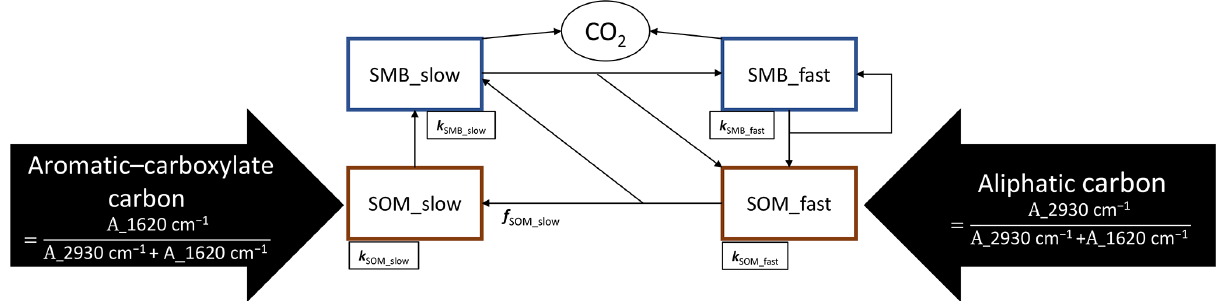
Figure 1. Original structure of the internal cycling of SOM in the Daisy model, as it was used in this study. A_2930cm − 1 and A_1620cm − 1 refer to the areas below the DRIFTS absorption bands at 2930cm − 1 and 1620cm − 1 (Eq. 3); k SOM and k SOM (fast and slow) are turnover rates of the fast and slow SOM and SMB pools, respectively, and f SOM_slow is the humification efficiency. All model parameters can be found in Table